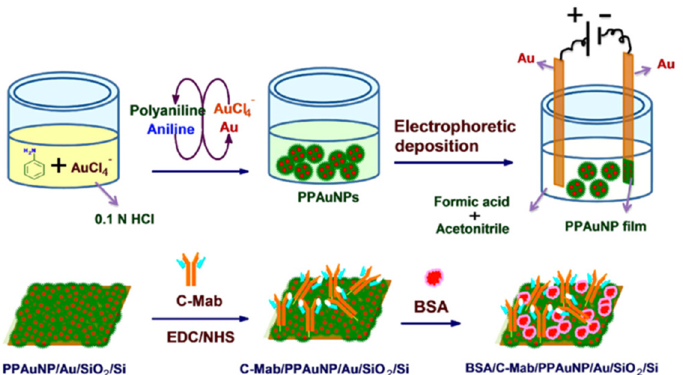
Figure 7. Schematic illustration of the fabrication of the BSA/C-Mab/PPAuNP/Au electrode for cor- tisol detection (reproduced with permission from [62]. Copyright 2015 Elsevier).